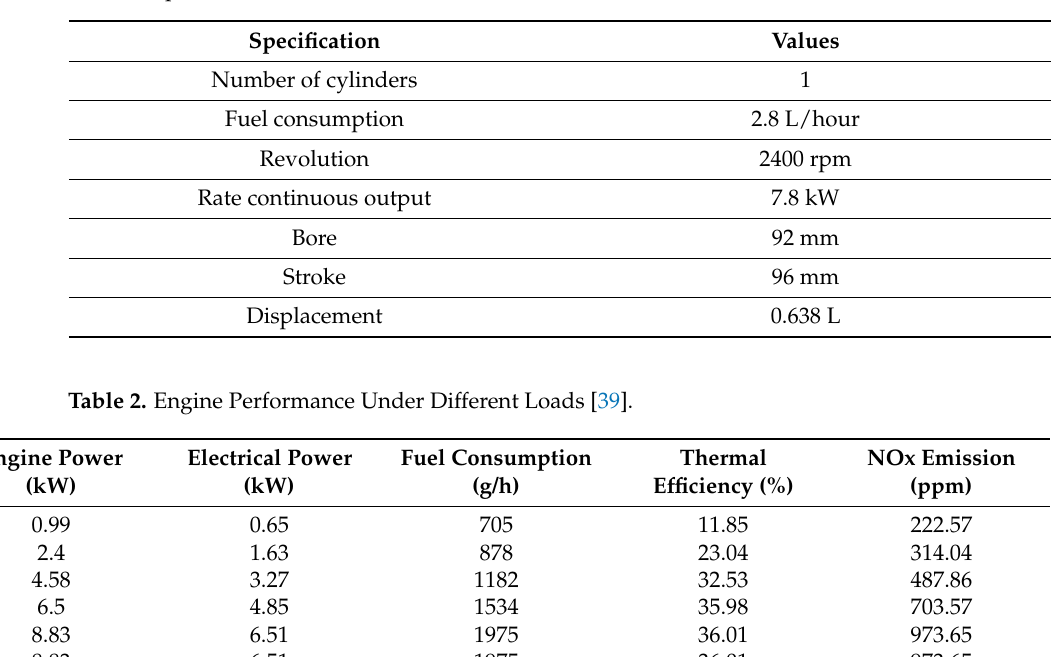
Table 1. Specifications of YANMAR TF 120 M [39].